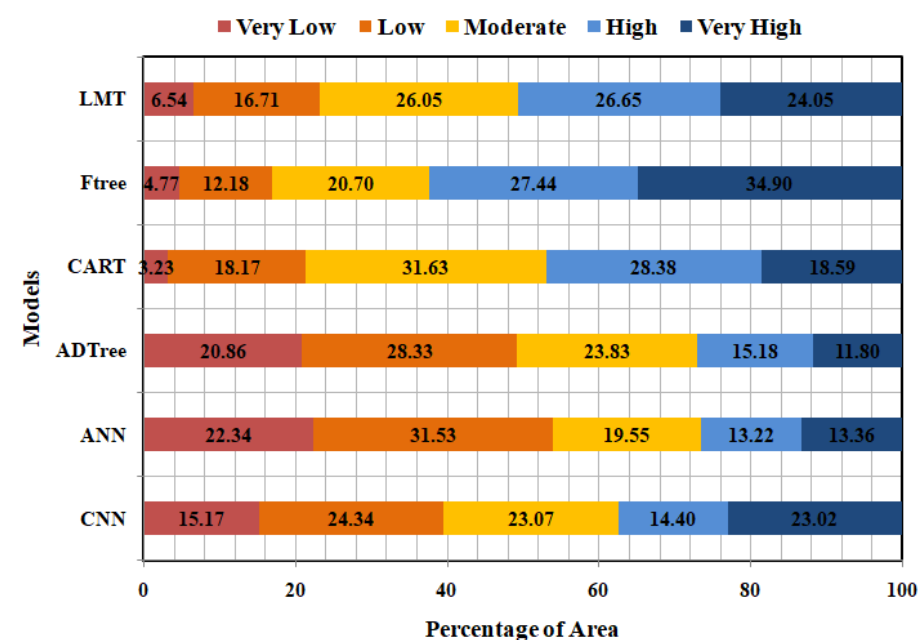
Figure 8. LSMs produced by the ML models: ( a ) CNN, ( b ) ANN, ( c ) ADTree, ( d ) CART, ( e ) FTree and ( f ) LMT.